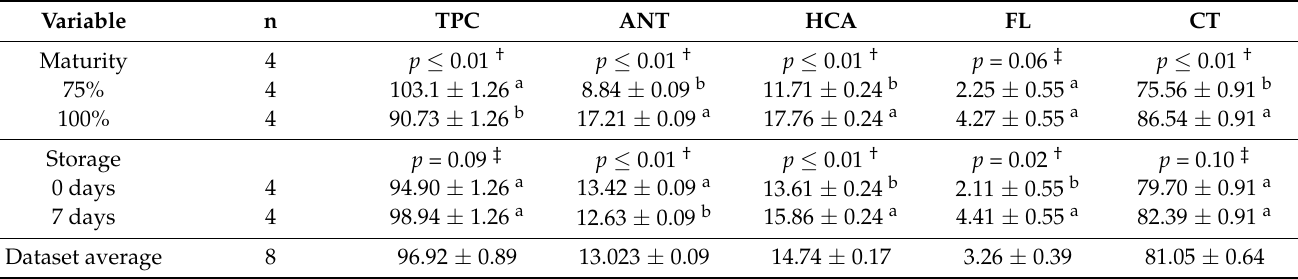
Table 3. Changes in the bioactive compounds in control juice samples during